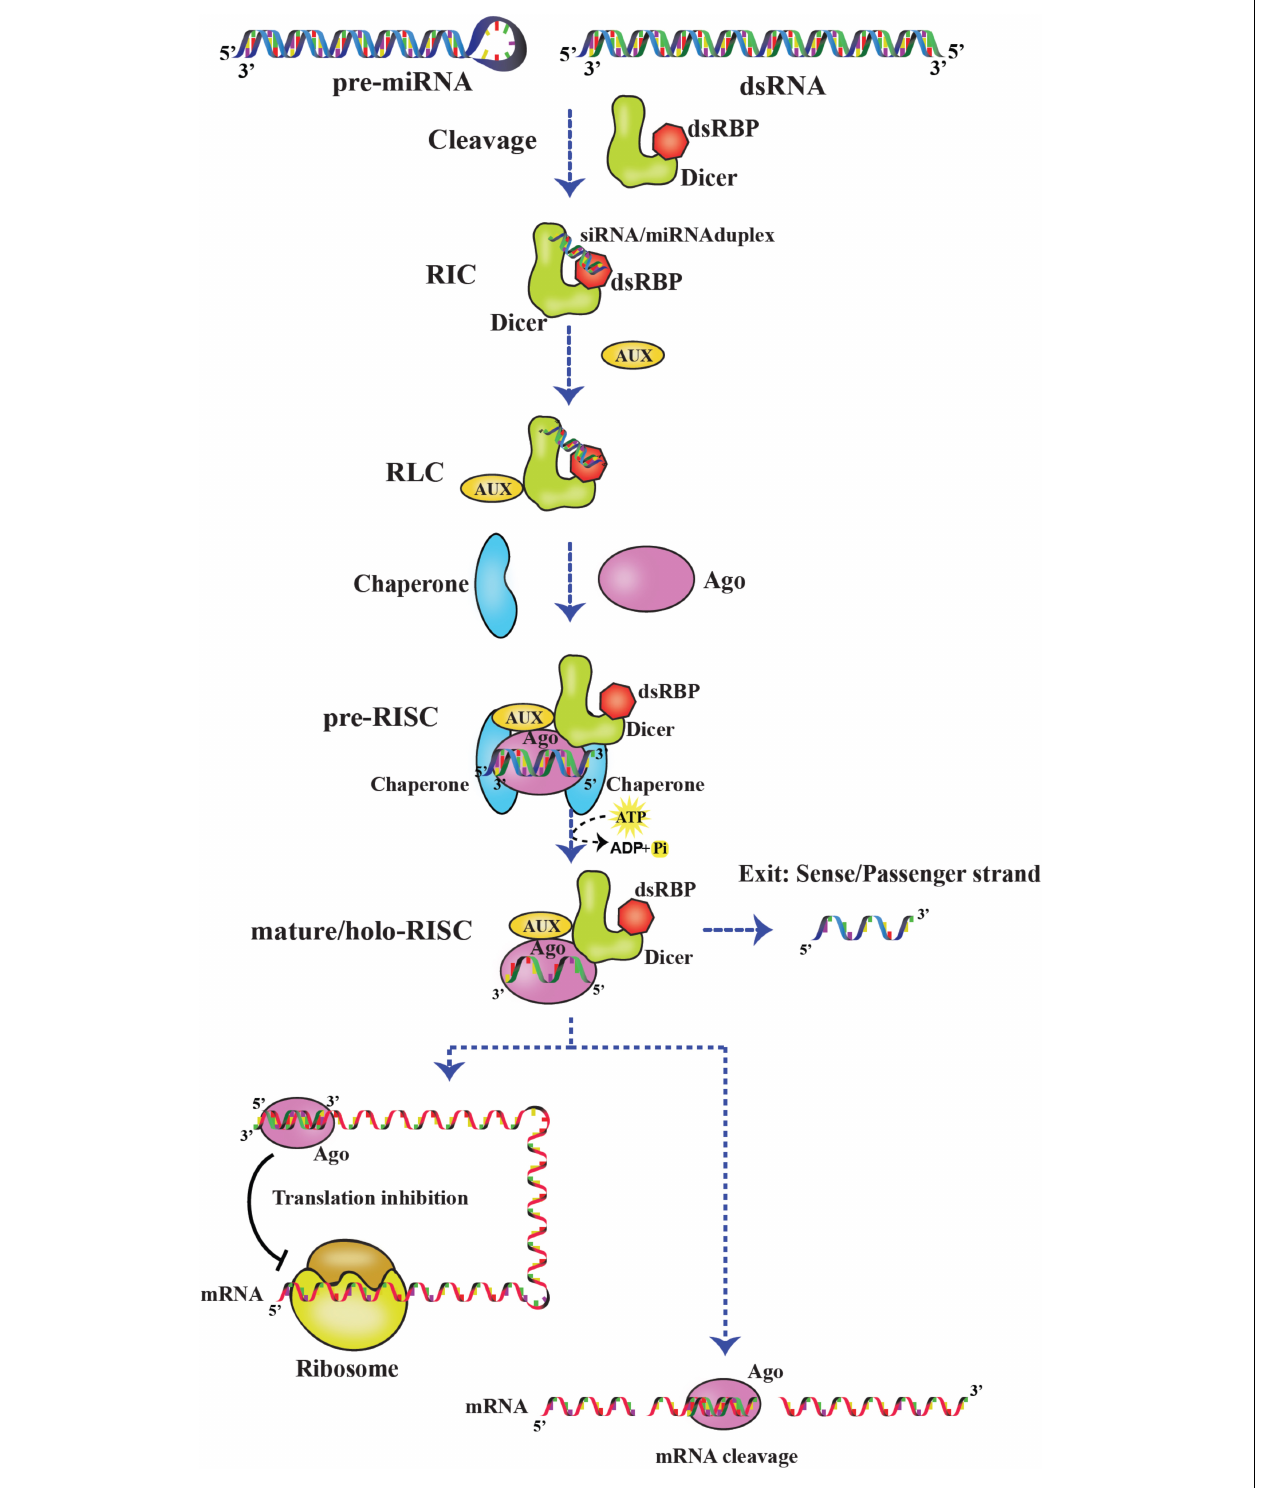
FIGURE 8 | RNA-induced silencing complex (RISC). Dicer:dsRBP complex cleaves pre-miRNA and dsRNA precursors to generate sRNAs. Later, the sRNAs are loaded on the Dicer:dsRBP complex to form RIC. Further, interaction with other auxiliary proteins (AUX) forms RLC. Ago interacts with RLC to form pre-RISC where the small RNA is loaded on Ago. The passenger strand exits and the guide strand is retained on Ago to form mature/holo-RISC. Based on the base pairing of the guide strand and target mRNA in the seed region, the mRNA is translationally inhibited or cleaved.